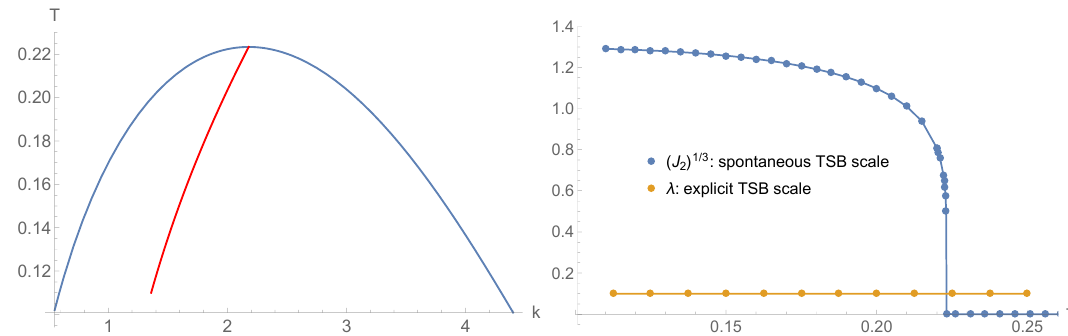
Figure 2 . Spontaneous translational symmetry breaking. Left: Bell curve of marginal modes for (cid:13) = 3 ; (cid:20) = 0 (blue), showing the temperatures at which the instability with given momentum k develops in the Reissner-Nordstrom background. This instability drives the spontaneous phase transition. The endpoint of the transition, the thermodynamically preferred non-linear solution has the momentum show by the red line. Right: temperature dependence of the order parameter | the expectation value for the spontaneous helical current J 2 as compared with the scale of the explicit pinning source (cid:21) = 0 : 1 (cid:22) . In all cases studied henceforth the pinning explicit scale is small compared to the spontaneous